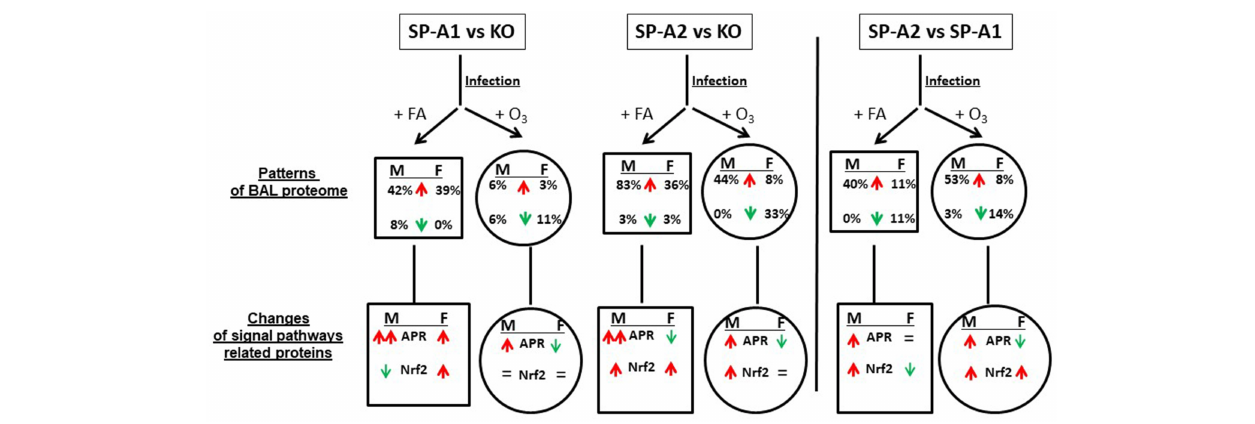
FIGURE 9 | A summary of the BAL proteome and signaling pathways in this study. This figure, following synthesis of all the data, depicts patterns of male (M) and female (F) mice of SP-A1 vs. KO, SP-A2 vs. KO, and SP-A2 vs. SP-A1 after FA or ozone exposure and bacterial infection. An up ( ↑ ) arrow (red) and down ( ↓ ) arrow (green) indicate increases ( > 25%) and decreases ( > -25%), respectively. The percentage of changed proteins ( > 25% increase or > -25% decrease) is shown under M and F. In the signaling pathway of related proteins, up ( ↑ ) arrows (red) indicate that the number of proteins involved in the signaling pathways with increases ( > 25%) is more than that of the proteins showing decreases ( > -25%). The number in double up ( ↑↑ ) arrows (red) is more than in single up ( ↑ ) arrows (red). Down ( ↓ ) arrows (green) indicates that the number of decreased proteins ( > -25%) is more than the number of increased proteins. “ = ” means no marked changes of proteins ( < 25%). Based on this model, we found differential effects of SP-A genotypes and sex on the patterns of BAL proteomes and signaling pathways in response to ozone exposure and bacterial